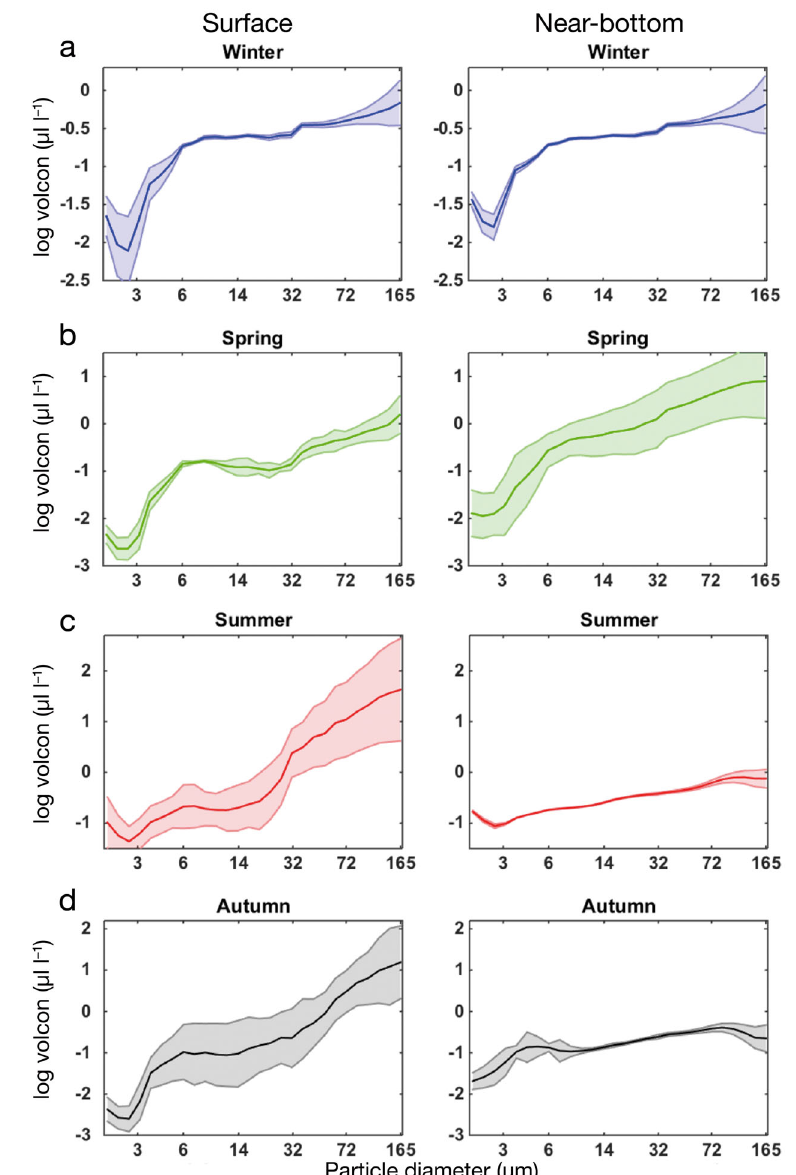
Fig. 4. Mean (solid line) and SD (shaded area) of volume concentration (vol- con) plotted against particle diameter for surface (left column) and bottom (right column) water to illustrate the difference between depths at Stn P1. January, April, August, and November data are shown to represent (a) winter, (b) spring, (c) summer, and (d)